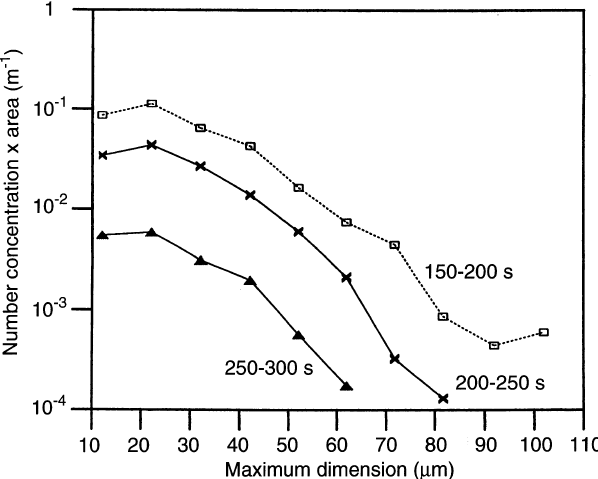
Fig. 7. Comparison between the measured and theoretical ice crystal scattering